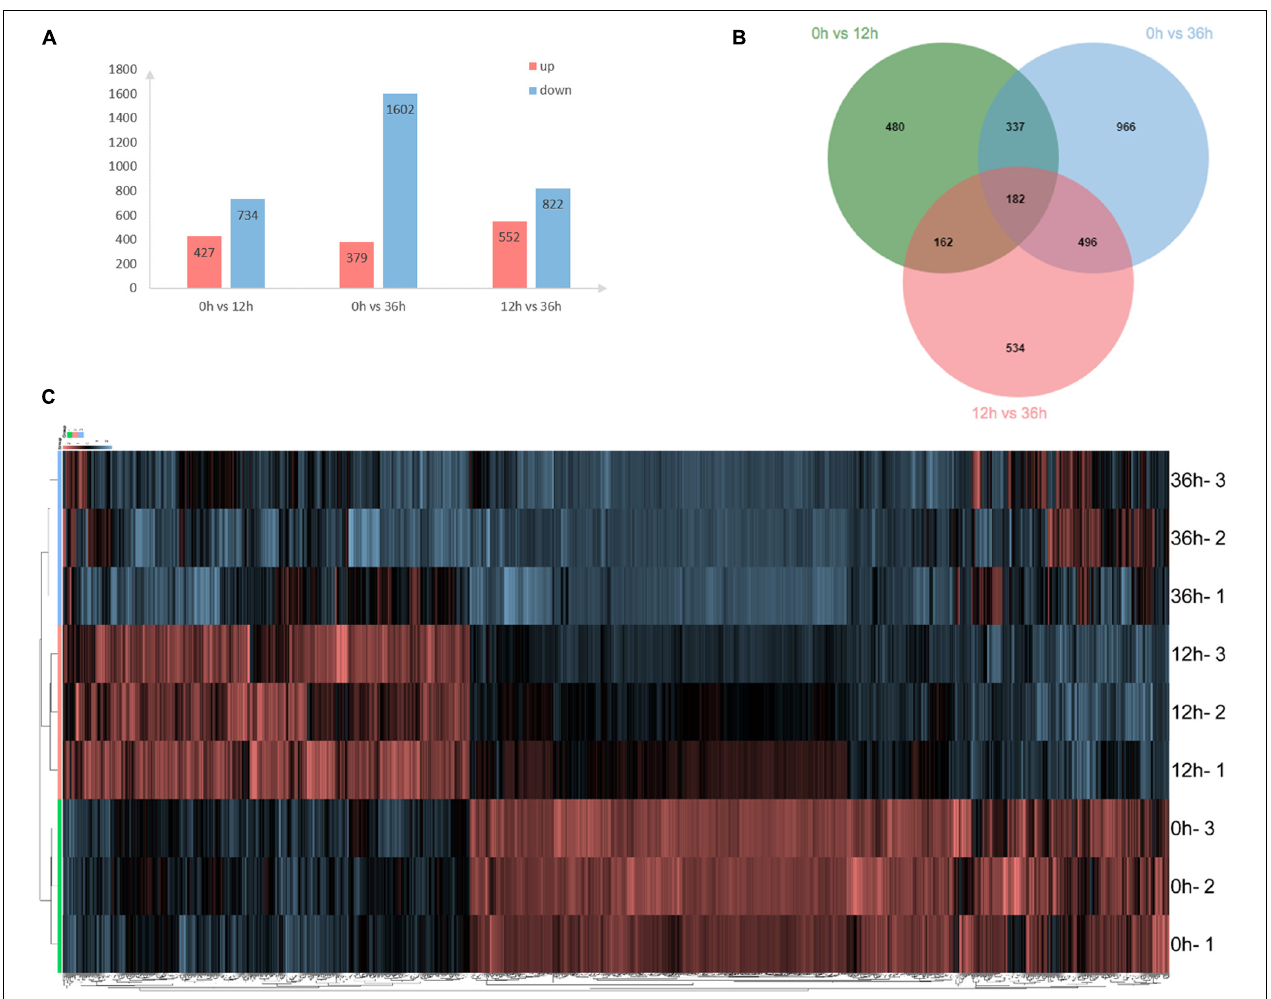
FIGURE 1 | Distributionlocations of differentially expressed genes in the transcriptome. (A) Distribution of differentially expressed genes (DEGs) following different time effects in gills of E. carinicauda . (B) DEGs number and Venn diagram of overlap of the different groups. (C) Hierarchical cluster analysis of differentially expressed genes based on the data of log 2